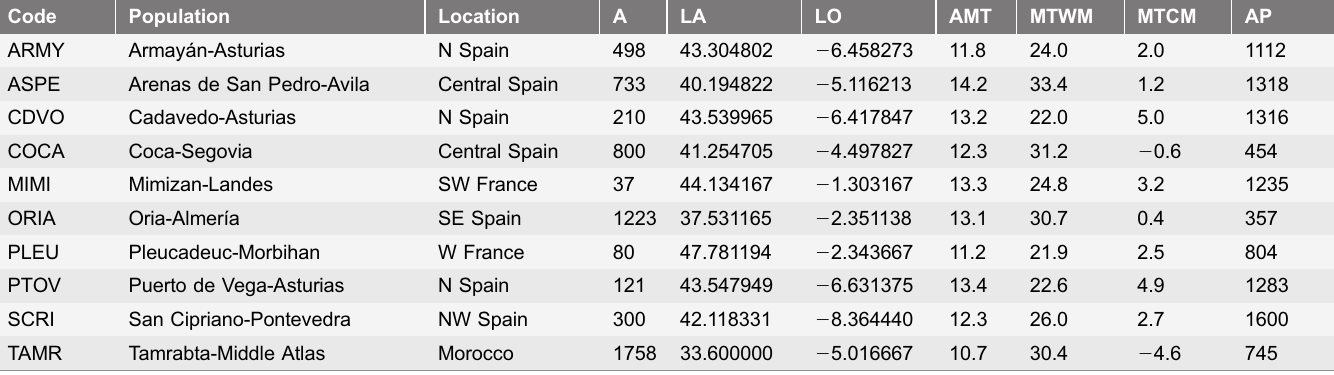
Table 1. Location, climatic data and altitude of the Pinus pinaster populations tested in 2012 (except CDVO) and 2013